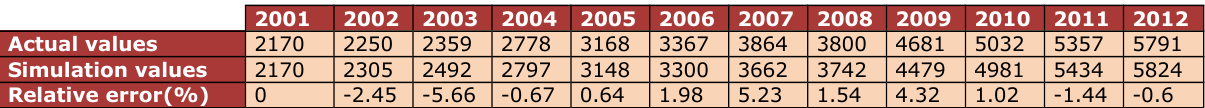
Table 1. Comparison of actual value and simulation value of national real estate